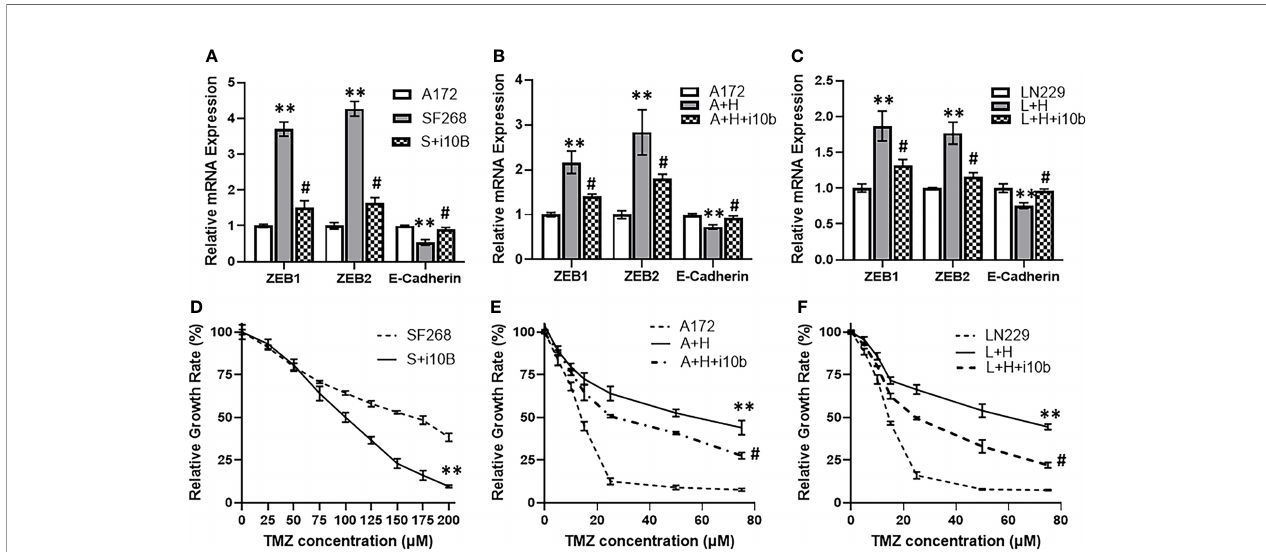
FIGURE 6 | Silencing of miR-10b reverses HOTTIP effects. (A) Expression levels of EMT markers were evaluated in A172 vs. SF268 cells (with and without miR-10b inhibition), by RT-PCR. The values in A172 cells were regarded as ‘ 1 ’ and relative values in SF268 cells are reported. GAPDH was evaluated as the endogenous control mRNA. (B, C) Expression levels of EMT markers were also evaluated in A172 and LN229 cells transfected with HOTTIP (with and without miR-10b inhibition), by RT-PCR. The values in control cells were regarded as ‘ 1 ’ and relative values in transfected cells are reported. GAPDH was evaluated as the endogenous control mRNA. MTT assays were performed to test the sensitivity of (D) SF268, (E) A172 and (F) LN229 glioma cells against TMZ after 3 day cycle, under different conditions. S+i10b: SF268 + anti-miR-10b, A+H: A172 cells with HOTTIP, A+H+i10b: A172 cells transfected with HOTTIP and anti-miR-10b. **p < 0.01 vs control, # p < 0.01 in miR-10b silenced cells vs. unsilenced (transfected with control anti-miRNA oligos)